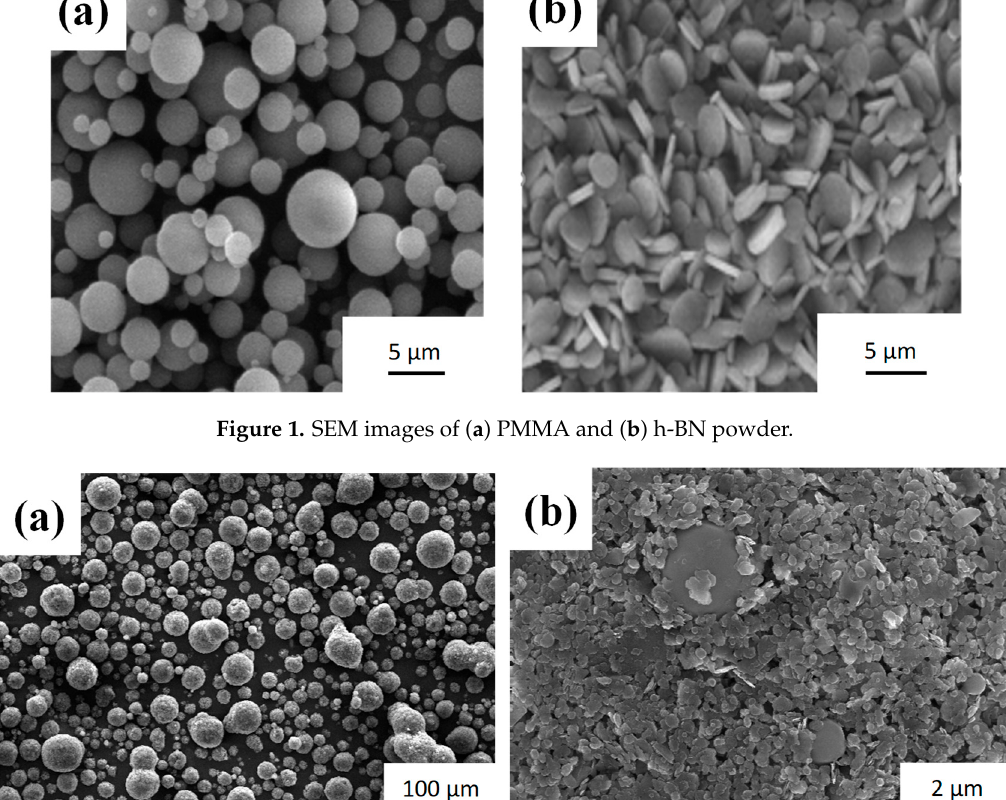
Figure 3. Particle size distribution of DP25B75 powder. For practical cosmetic application, the oil absorption property is important and Figure 4a shows the oil absorptions of pristine PMMA, h-BN, and DP25B75 composite powders. Spherical PMMA with an average particle size of 4 μ m exhibited an oil absorption of 98 g/100 g. Plate-like h-BN with a smaller particle size (2 μ m) exhibited a better oil absorption property of 169 g/100 g , whereas DP25B75 exhibited a superior oil absorption ability of 259 g/100 g. It should be noted that spray-dried